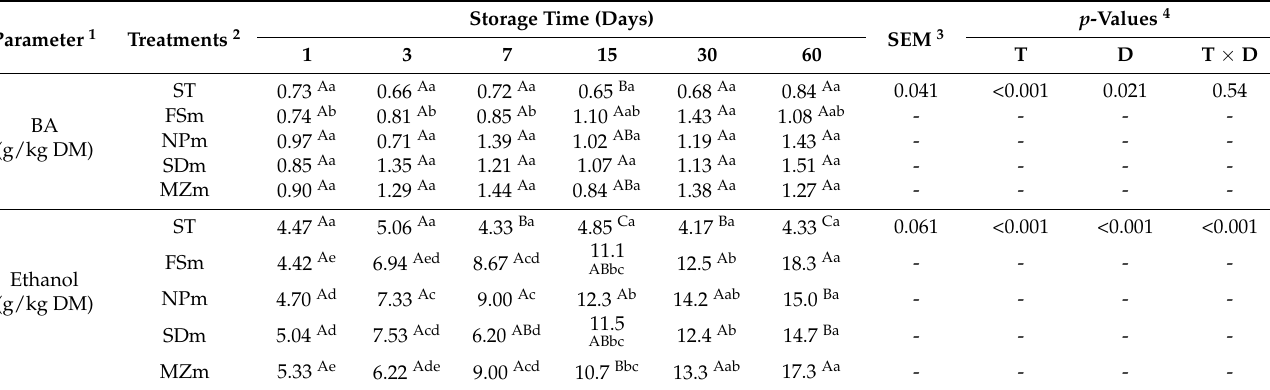
Table 3. Dynamics of ethanol and BA concentrations during 60 days ensiling of forage sorghum